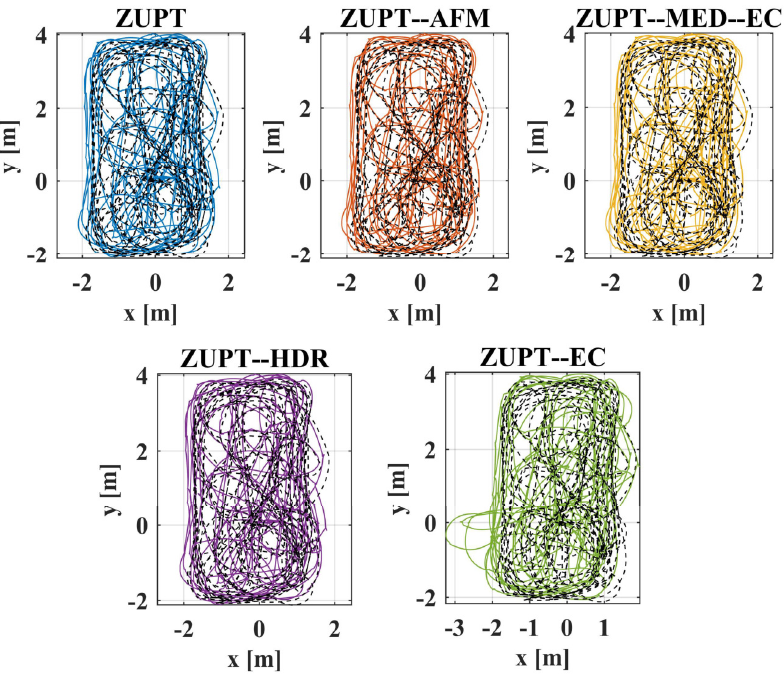
Figure 5. Estimated trajectories of different frameworks (colored lines) and the optical reference trajectory (dashed